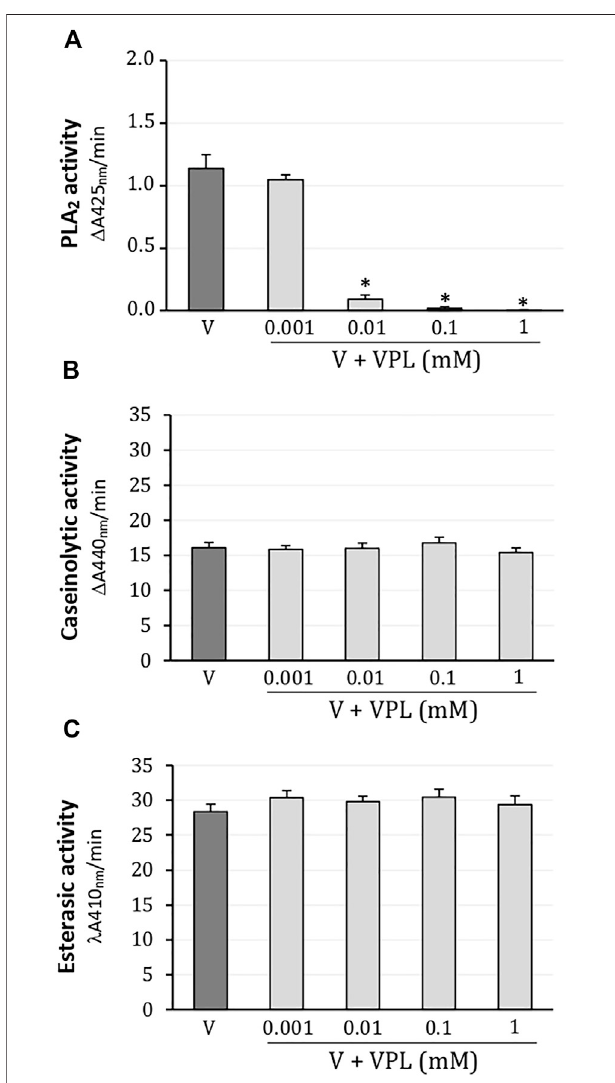
FIGURE 1 | Action of varespladib on the major enzymatic activities of L. m. rhombeata venom. (A) Varespladib abolished the PLA 2 activity at low concentrations. Unaffected (B) caseinolytic and (C) esterasic activities by varespladib at any tested concentration. Bars represent the mean ± SDM ( n (cid:1) 5). * p < 0.05 compared to venom